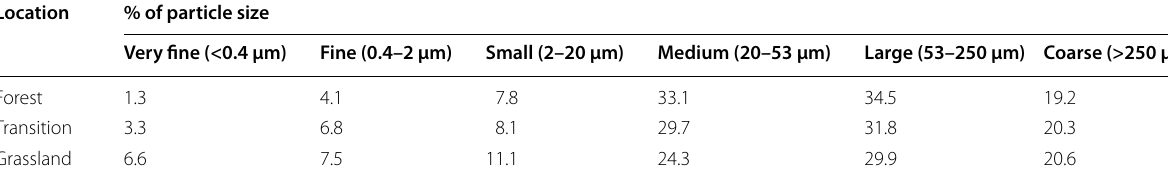
Table 2 Particle-size distribution in different sampling locations Location